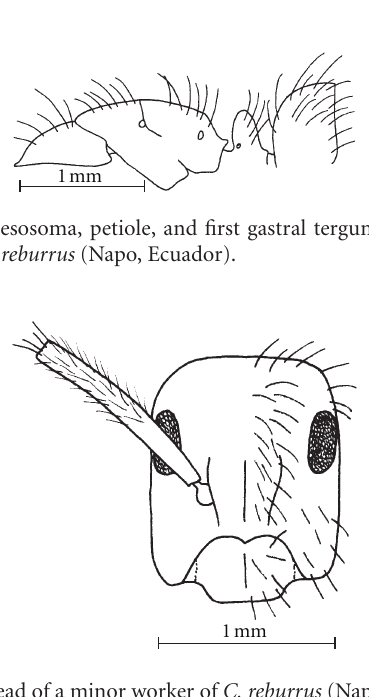
Figure 2: Head of a minor worker of C. reburrus (Napo,